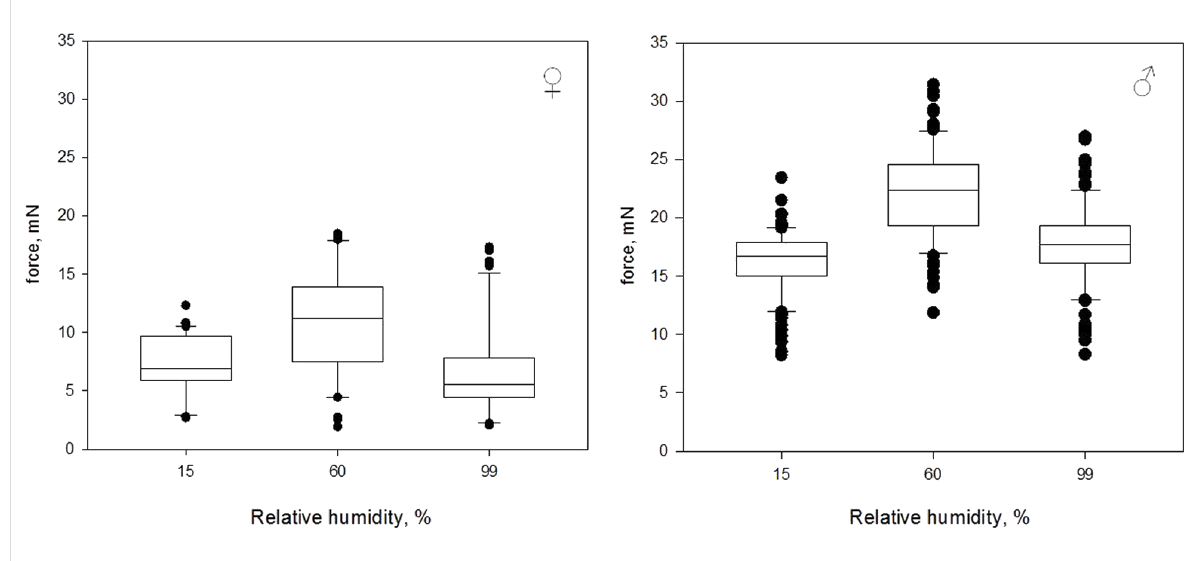
Figure 3: Box-and-whiskers plots, based on the results of the first experiment, with one RH level tested per day. The ends of the boxes de fi ne the 25th and 75th percentiles, with a line at the median and error bars de fi ning the 10th and 90th percentiles, black dots represent the outliers.